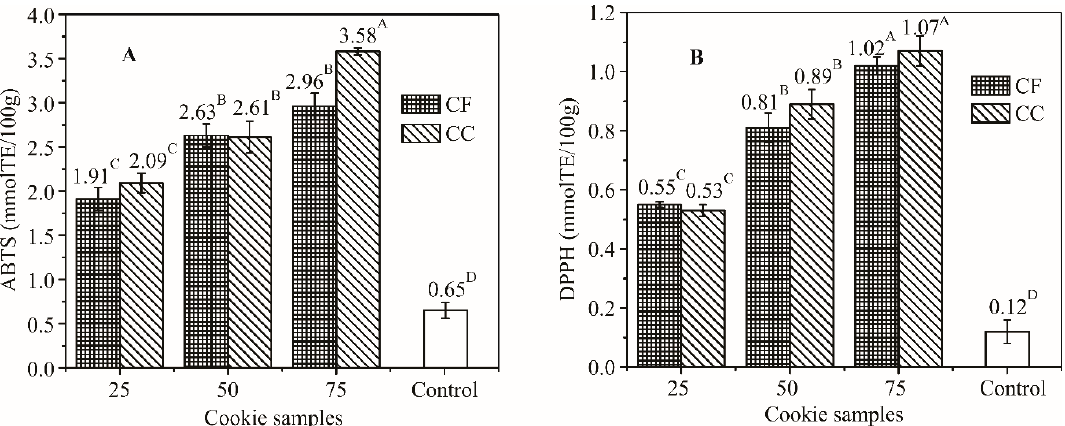
Figure 2. Increase of antioxidant (AO) activity of cookies determined by the ABTS ( A ) and DPPH ( B ) test in relation to the percentage of wheat flour substituted with coarse and fine APF (different superscripts indicate significant differences of means, according to Tukey’s HSD test ( p < 0.05)).